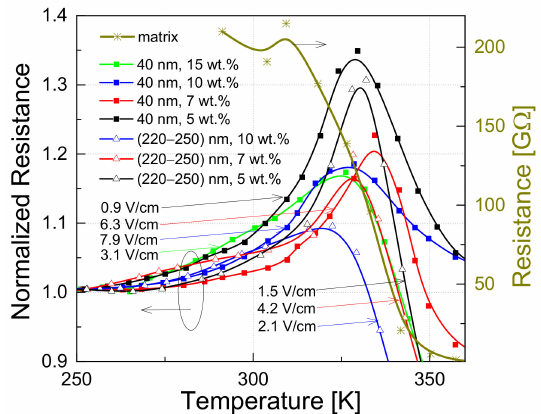
Figure 5. Dependence of the normalized resistance on temperature of composites and the polymer matrix, measured at different voltages depending on the sample resistance. The electrical field values applied to the sample at room temperature are